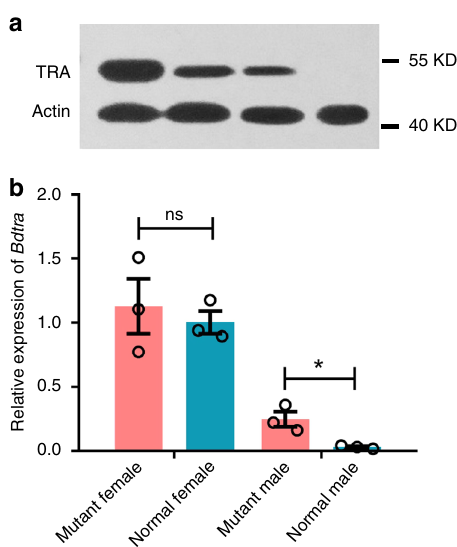
Fig. 9 The effect of miR-1-3p on Bdtra expression. a A Western blot showing BdTRA protein levels in normal and miR-1-3p mutant females and males, and ( b ) relative Bdtra mRNA levels by qPCR in normal and miR-1-3p mutant females and males. Error bars indicate the SEM of three independent biological replicates and asterisks (*) indicate the statistically signi fi cant differences ( P < 0.05) between the treatment group and control group based on Student ’ s t test. Ns indicate no statistically signi fi cant difference between treatment group and the control